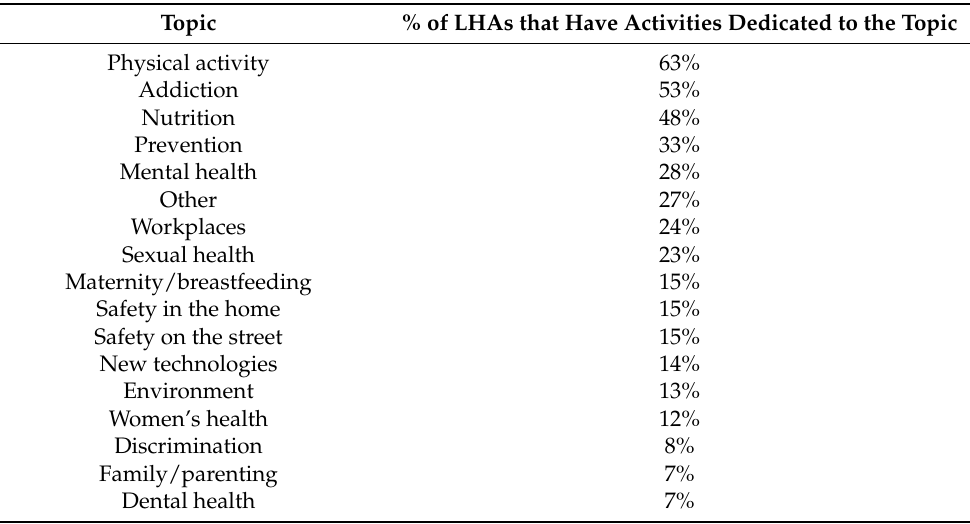
Table 2. Percentage of LHAs in Italy having projects dedicated to a specific topic. Topic % of LHAs that Have Activities Dedicated to the